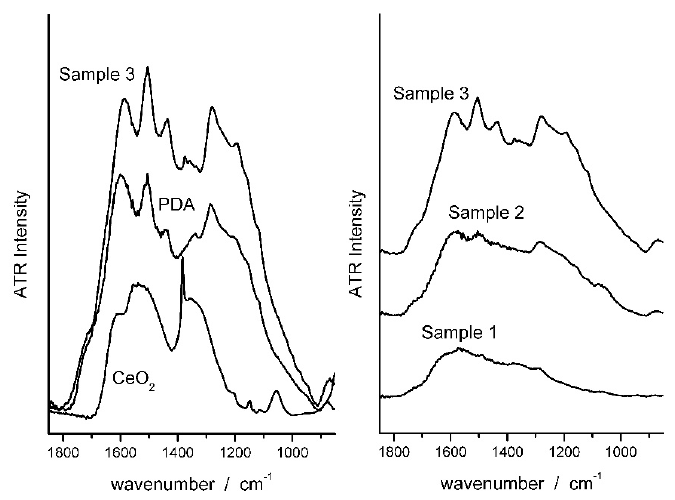
Figure 1. ATR spectra of CeO 2 , PDA and PDAx@ CeO 2 samples.